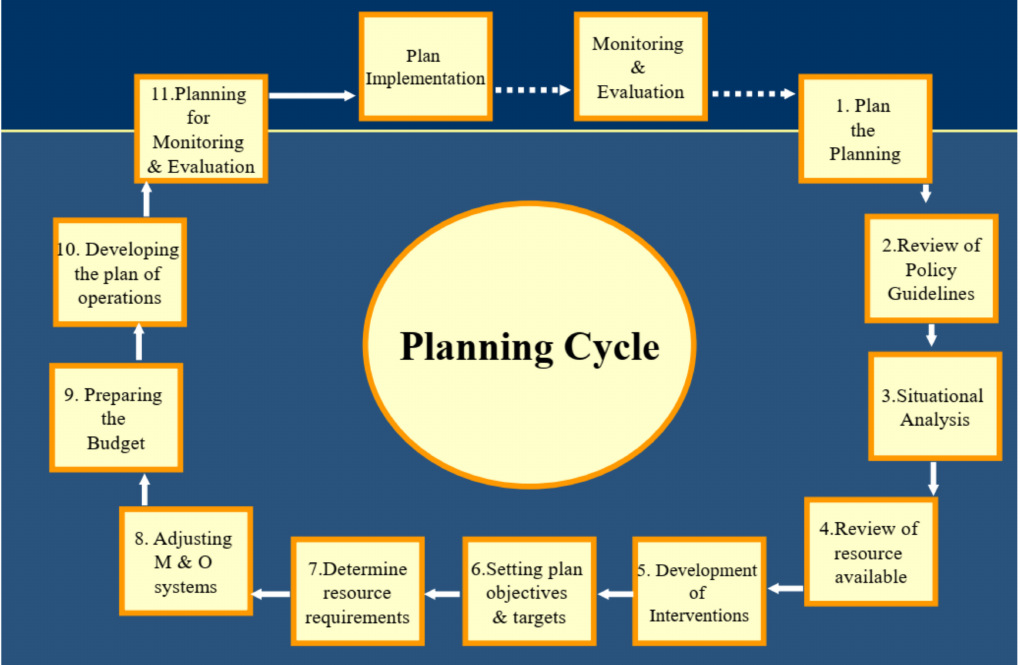
Figure 3. Planning